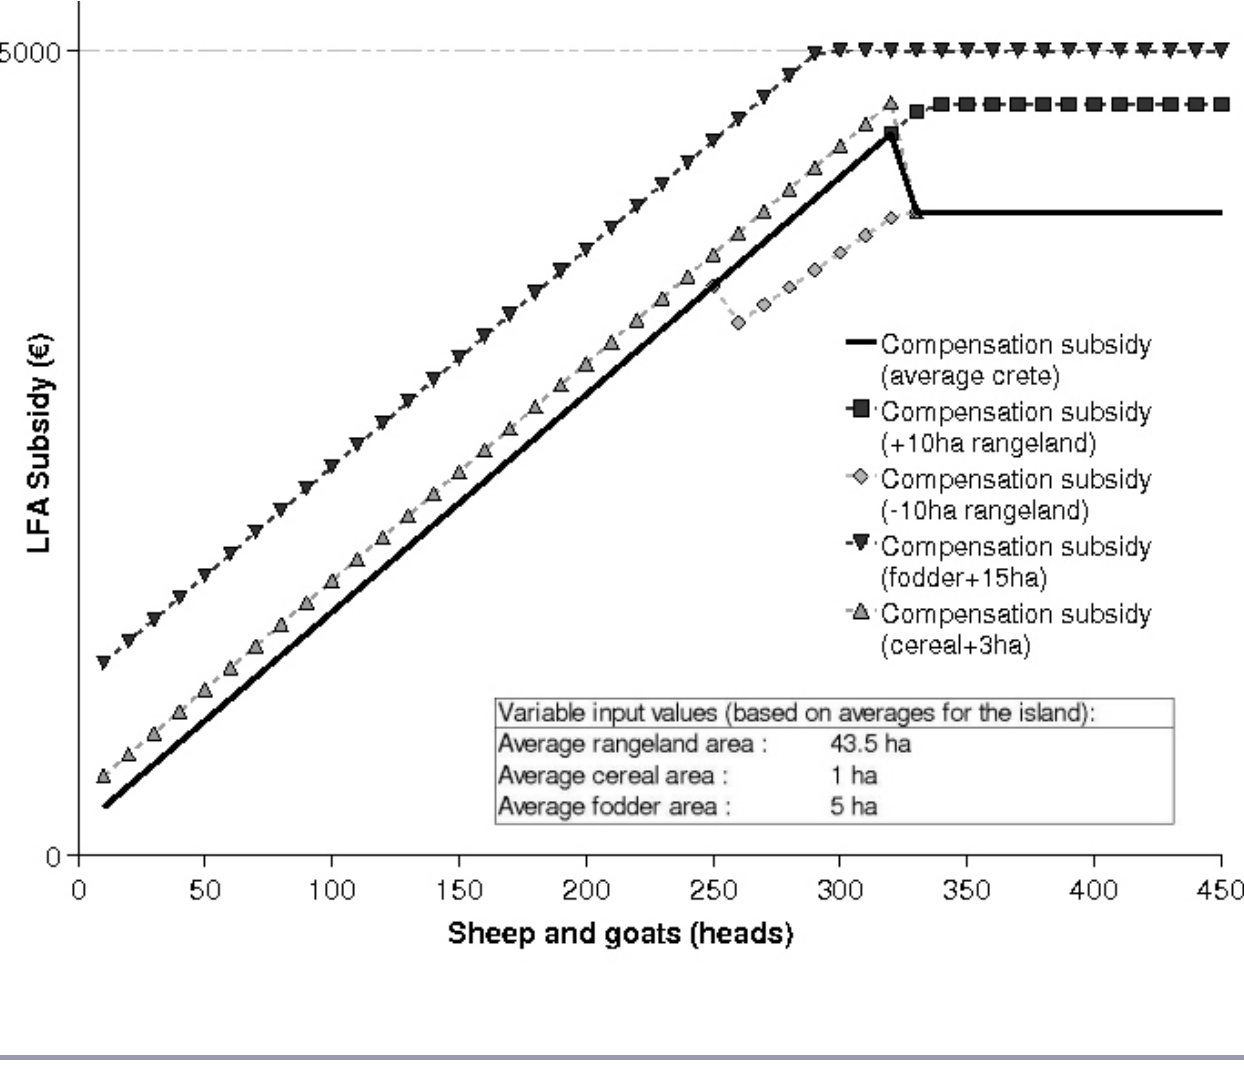
Figure 4. Less Favoured Area (LFA) subsidy as a function of sheep and goats per